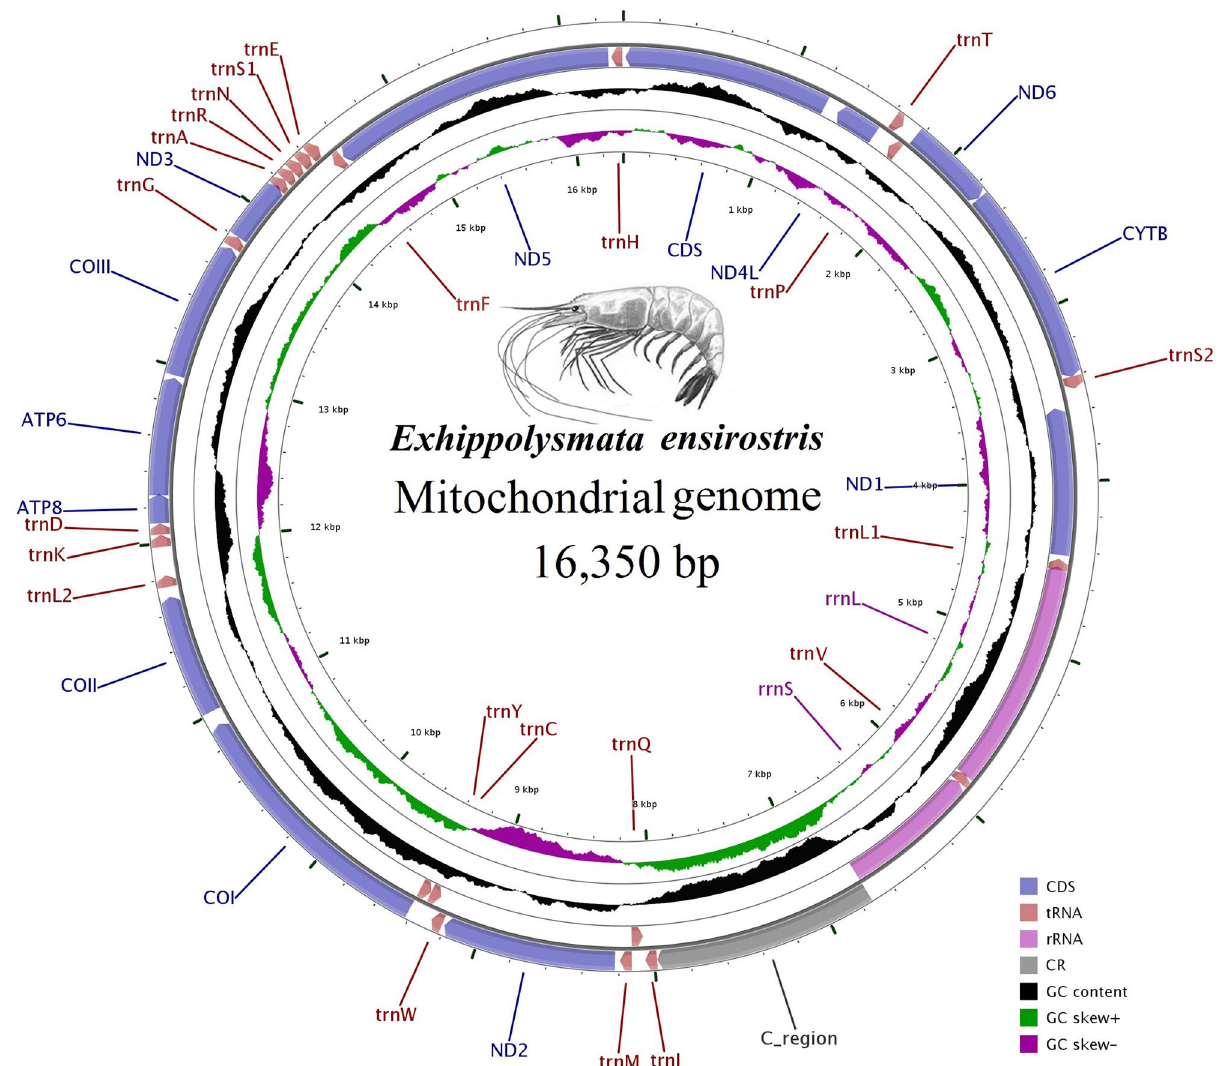
Figure 1. Circular mitogenome map of Exhippolysmata ensirostris . Protein coding, ribosomal and tRNA genes are shown with standard abbreviations. Arrows indicate the orientation of gene transcription. The inner circles show the GC content and GC skew, which are plotted as the deviation from the average value of the entire